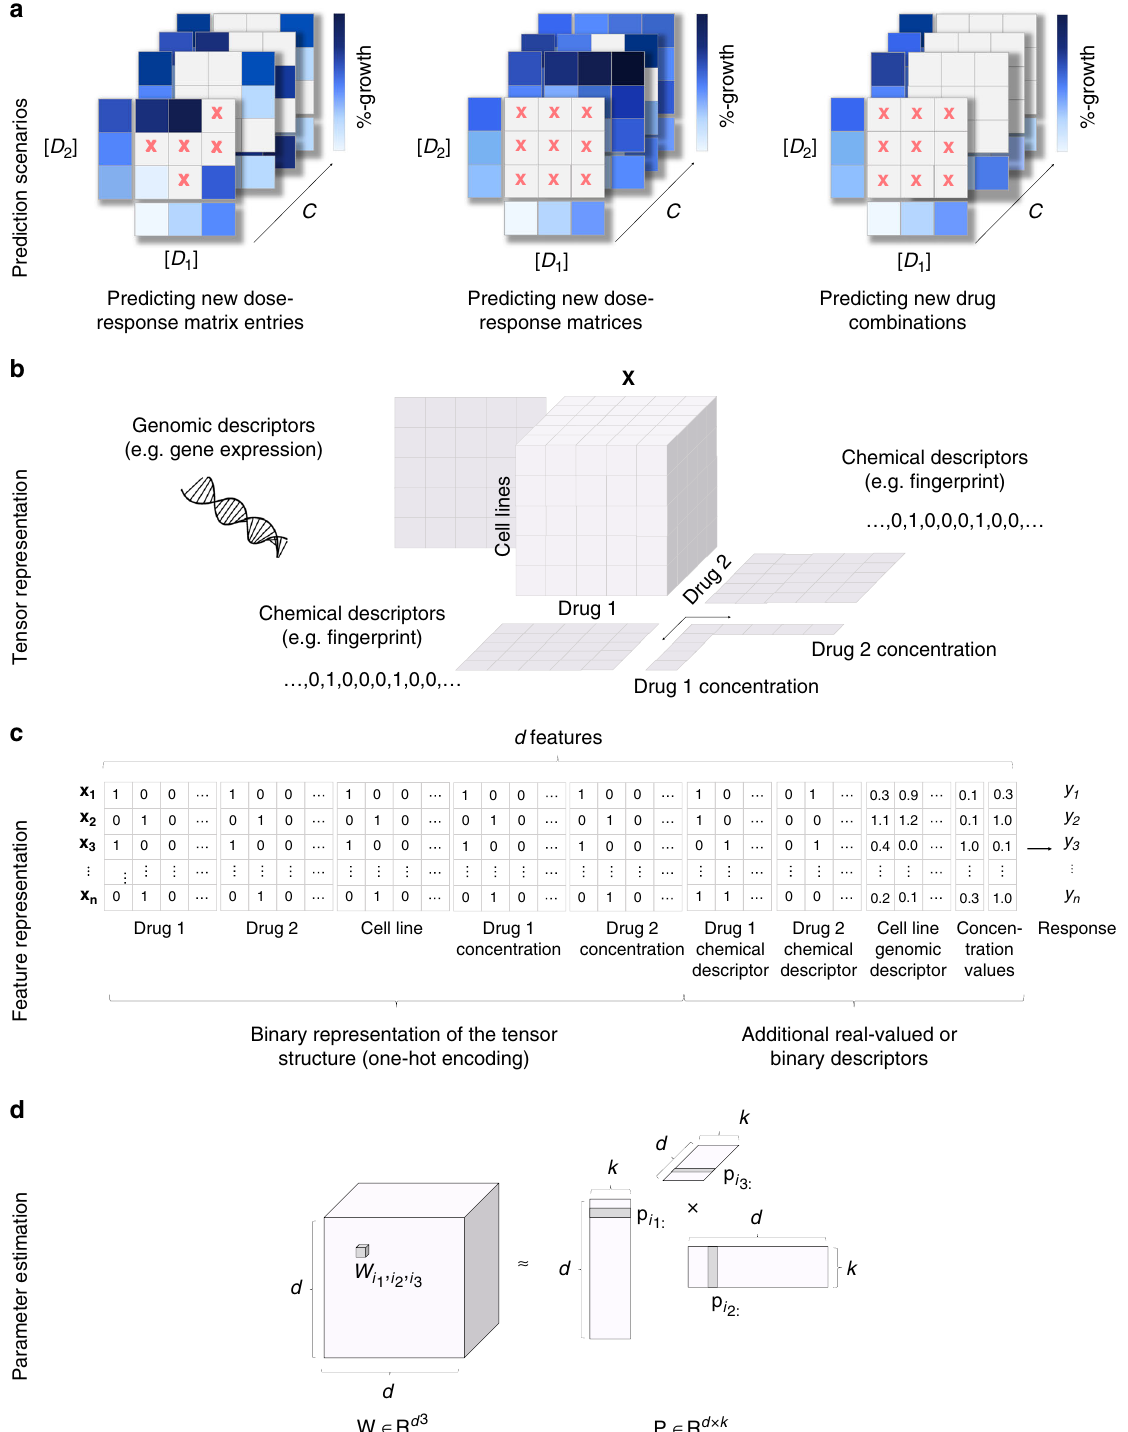
, for a t th order combination ( t = 3 1 ; i 2 ; ¼ ; i t